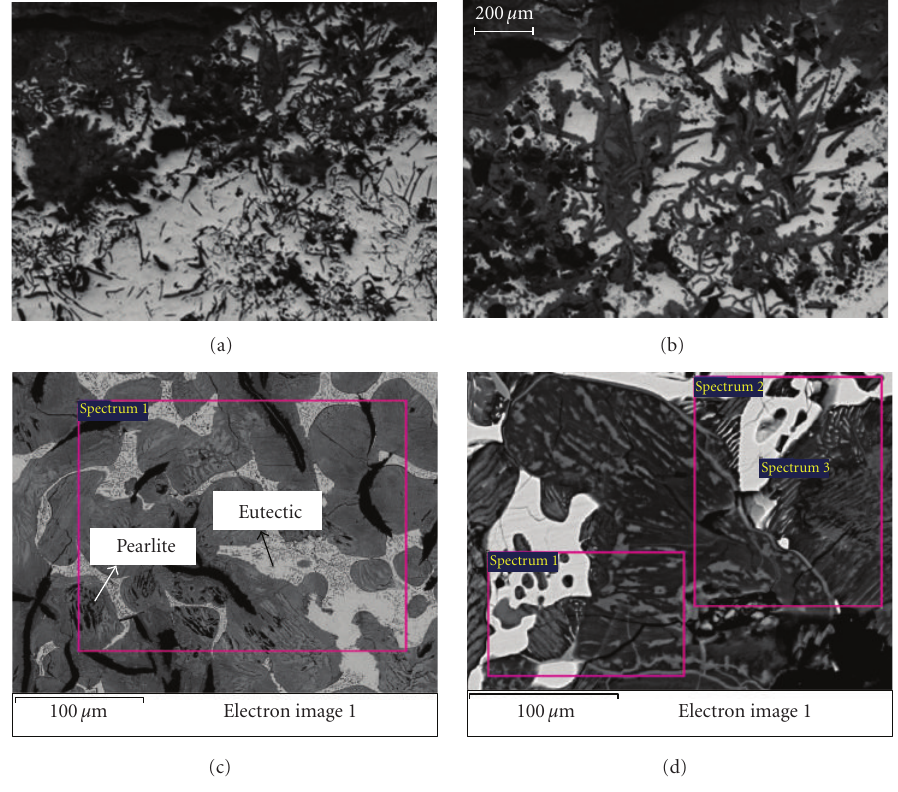
Figure 9: SEM images of corroded zone of exservice